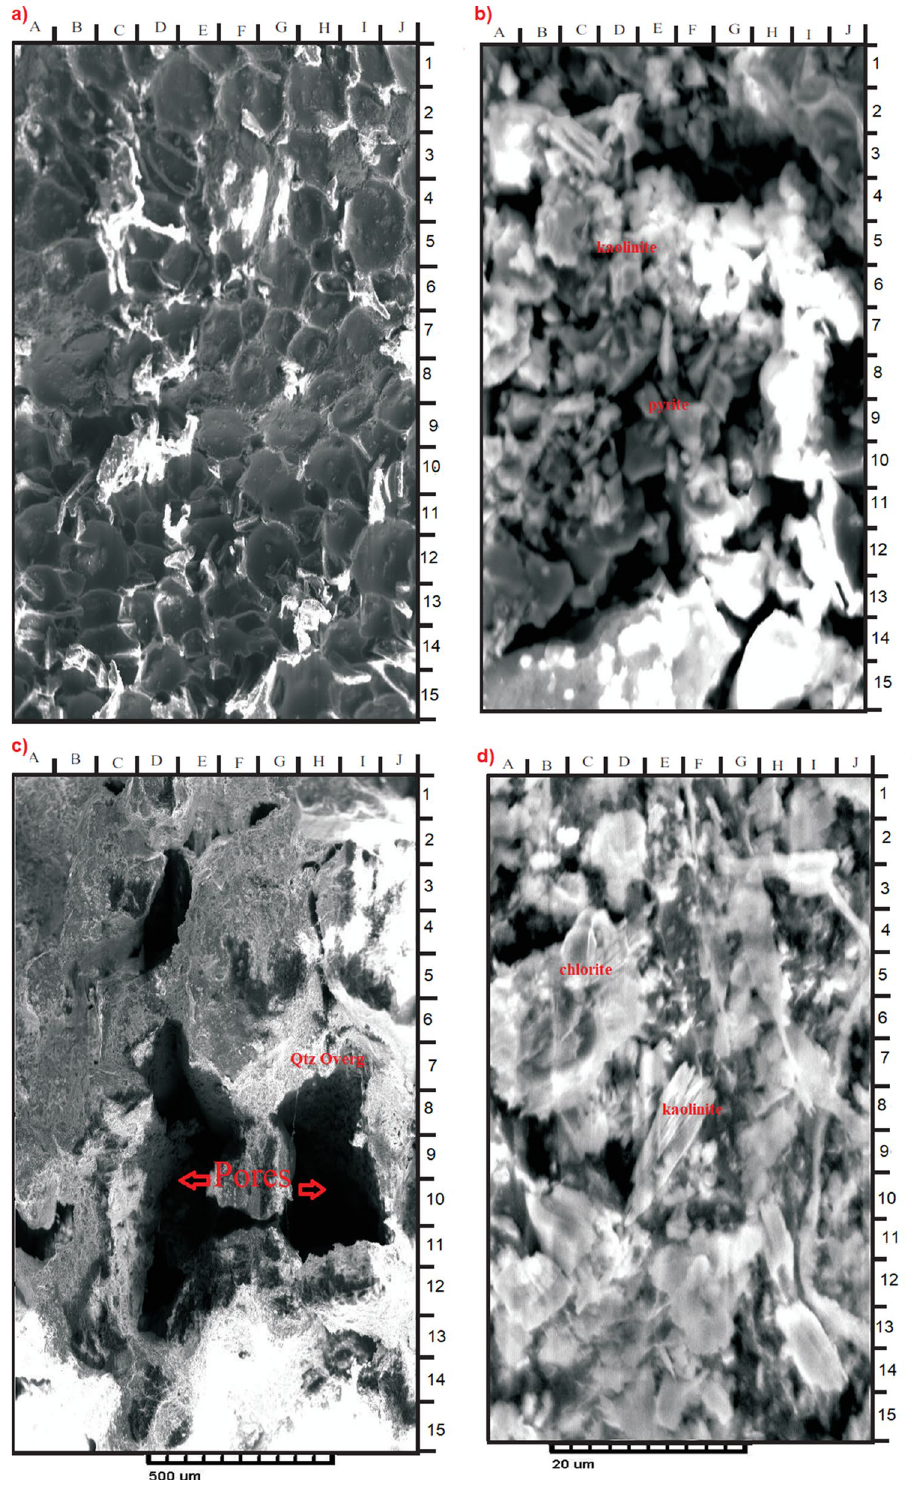
Figure 10. ( a ) High cemented with relative closed grain packing and low degree of intergranular porosity. ( b ) Few amounts of stacked pseudo hexagonal plates of kaolinite partially filling a pore (( b ) E–F 5–6). Considerable amount of pyrite, which observed within the pores (( b ) C–F 7–8; E–F 11–12). Few quantities of iron oxides occur between the detrital grains (( b ) B–C 6; F7). Minor amount of carbonate (( b ) F–G 8–9). ( c ) Moderately cemented with relatively open grain packing and medium degree of primary intergranular porosity (( c ) D–E 2–5 & D–G 6–12). ( d ) Common corroded detrital plates of kaolinite partially filling some pores and partially cover some detrital grains (( d ) C–D 2–4 & E–H 11–13). Some authigenic kaolinite appears as pseudohexogonal plates or books arranged faceto- face into an elongated stacked form called verm ( d ): D–G 7–10 & A–B 11–12) Some rose-like shape of chlorite (( d ) A–D